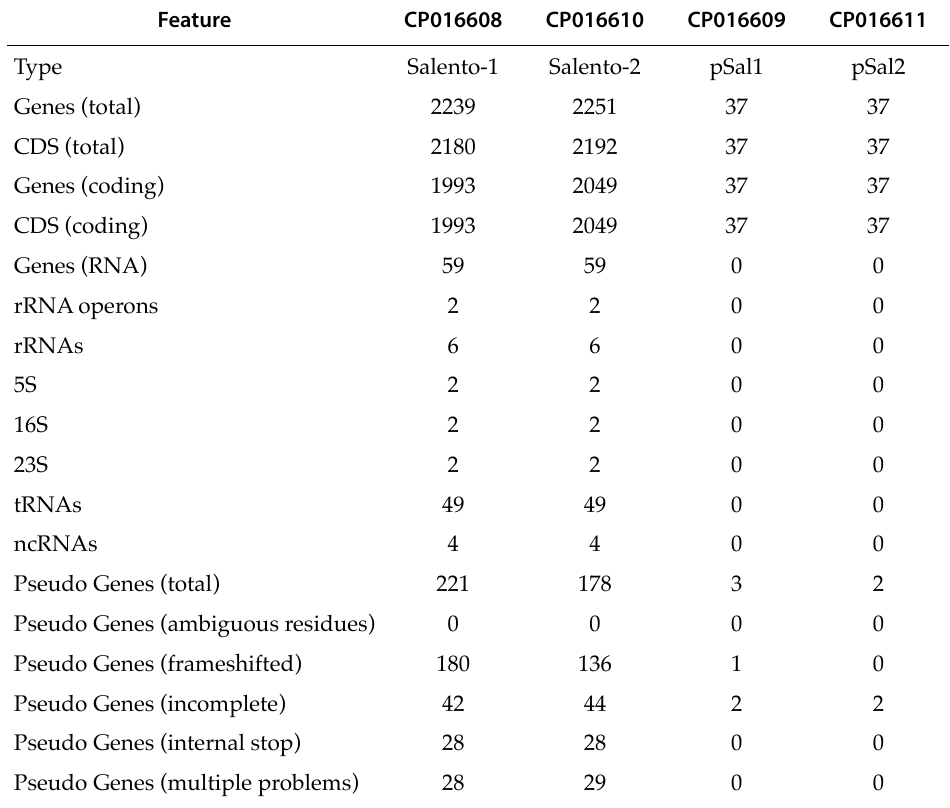
Table 2. Annotation results of the genomes and pSal1 (CP016609) and pSal2 (CP016611) plasmids of Xylella fastidiosa